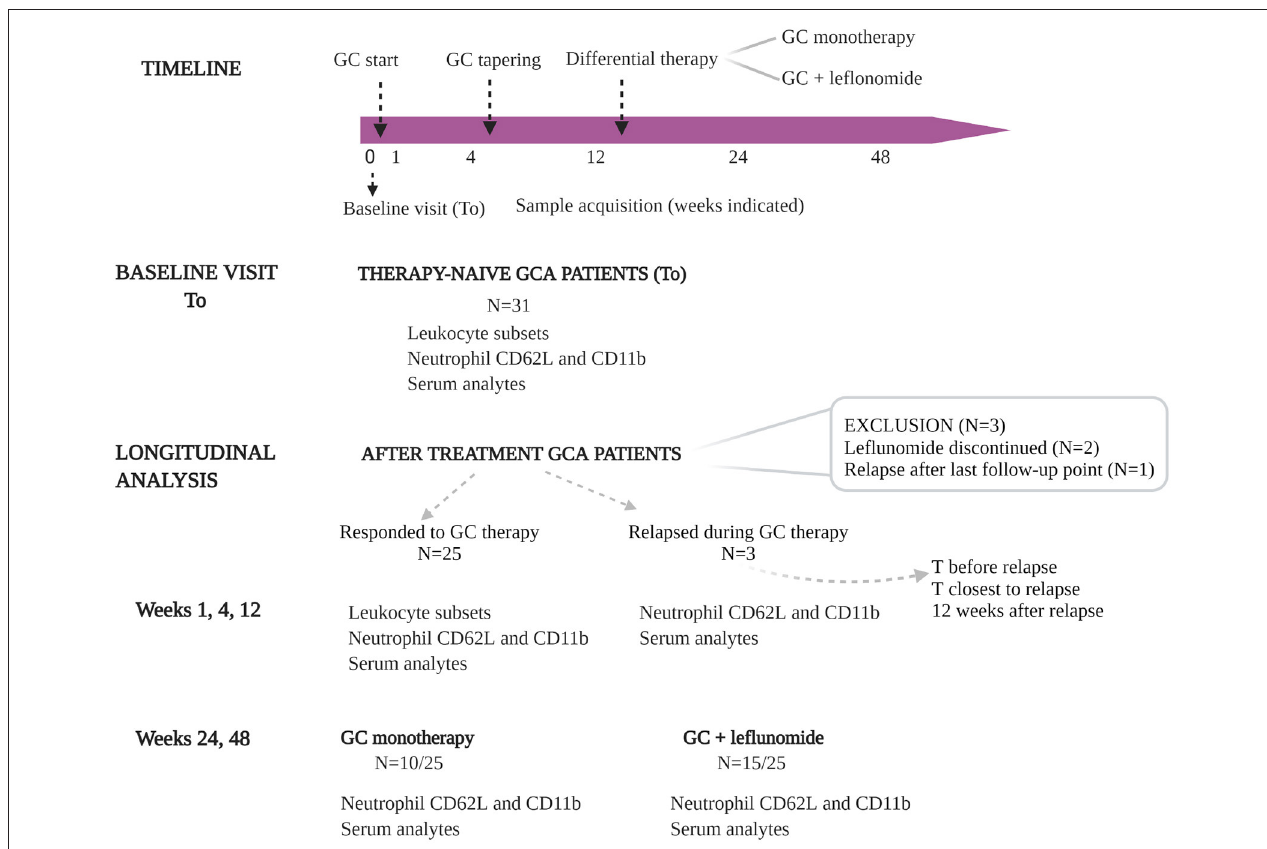
FIGURE 1 | Overview of the study design. Thirty-one consecutive, therapy-naïve GCA patients were included in the study. Blood samples from GCA patients were obtained at baseline visit [before initiation of GC therapy (T 0 )], and during follow-up at weeks 1, 4, 12, 24, and 48. GC treatment was initiated at the time of diagnosis. GC tapering started at week 4 after sampling. Leflunomide (10 mg/day) was introduced as an adjuvant therapy at week 12 to 17 GCA patients (two of them experienced therapy-related adverse events and were excluded from longitudinal analysis). During follow-up and GC tapering, three of 25 patients experienced disease relapse after they already responded to GC therapy. At the time of relapse these patients were on GC monotherapy and consequently received leflunomide (10 mg/day), in addition to GC. From 3 relapsing patients, the data was collected before relapse, at the time closest to relapse and 12 weeks after relapse. GC, glucocorticoids; GCA, giant cell arteritis; T,